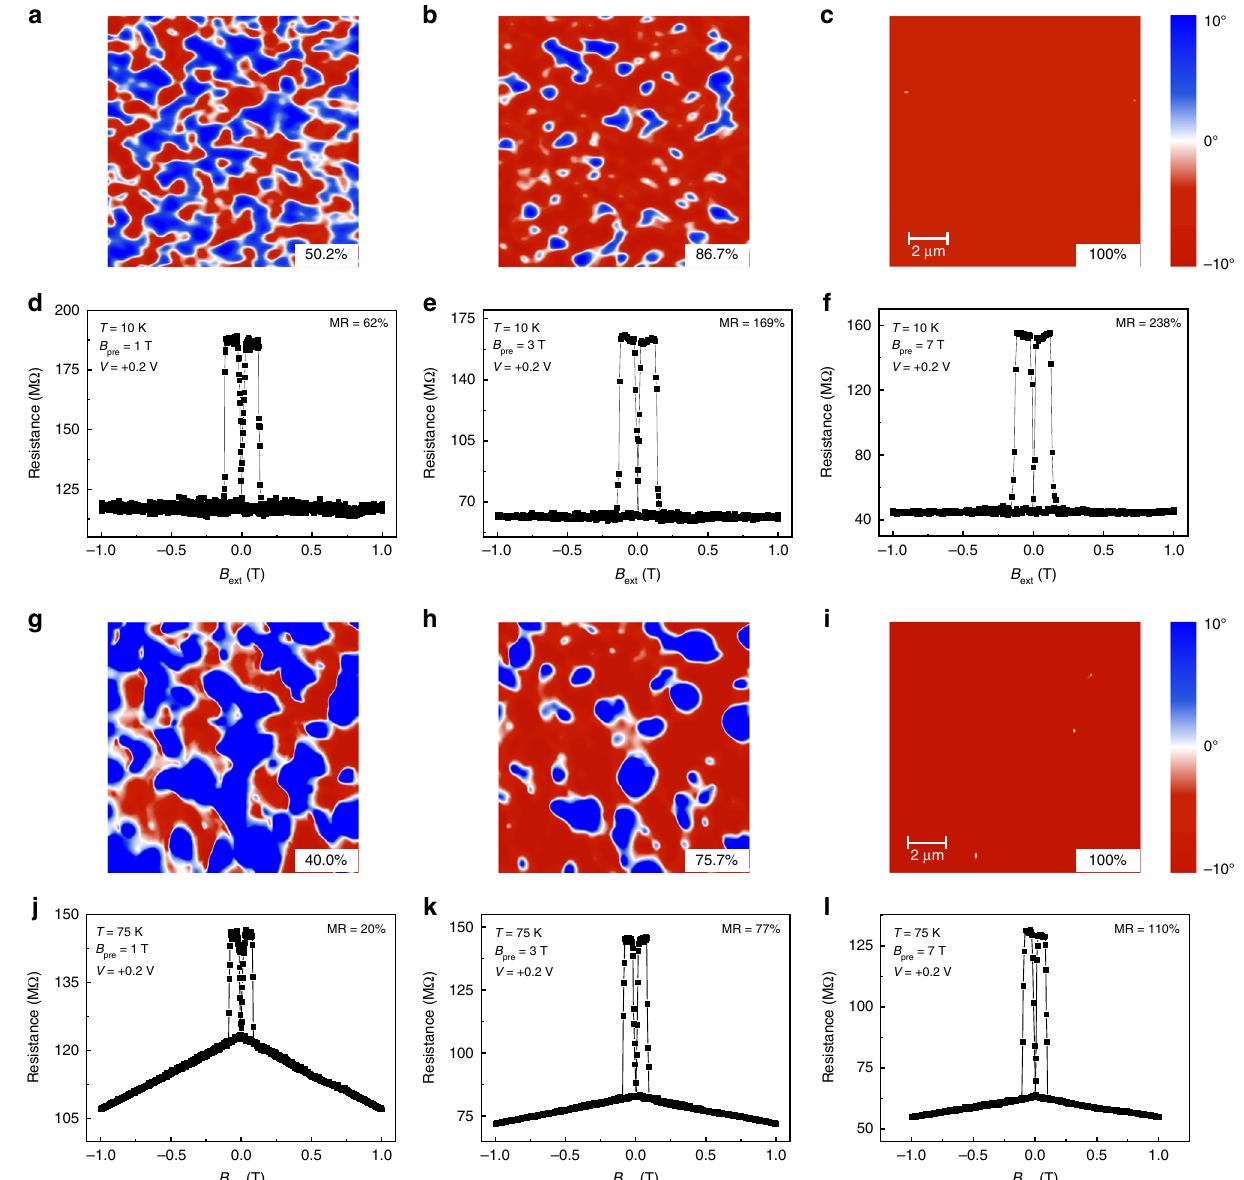
Fig. 4 Temperature and pre-set magnetic fi eld controlled EPS and MR response. a – c The obtained EPS image by magnetic force microscope in the LPCMO thin fi lm at 10 K after applying the pre-set magnetic fi eld, B pre = 1 T, 3 T, and 7 T, respectively. The red area in the MFM image represents the FMM phase, while the blue area refers to the COI phase. All the MFM images were taken at a constant magnetic fi eld ( B ext = 1 T) after withdrawing B pre . d – f The corresponded MR response in the LPCMO-OSV device under the same condition. The obtained EPS image ( g – i ) and MR ( B ext ) loops ( j – l ) at 75 K after applying the pre-set magnetic fi eld, B pre = 1 T, 3 T, and 7 T,